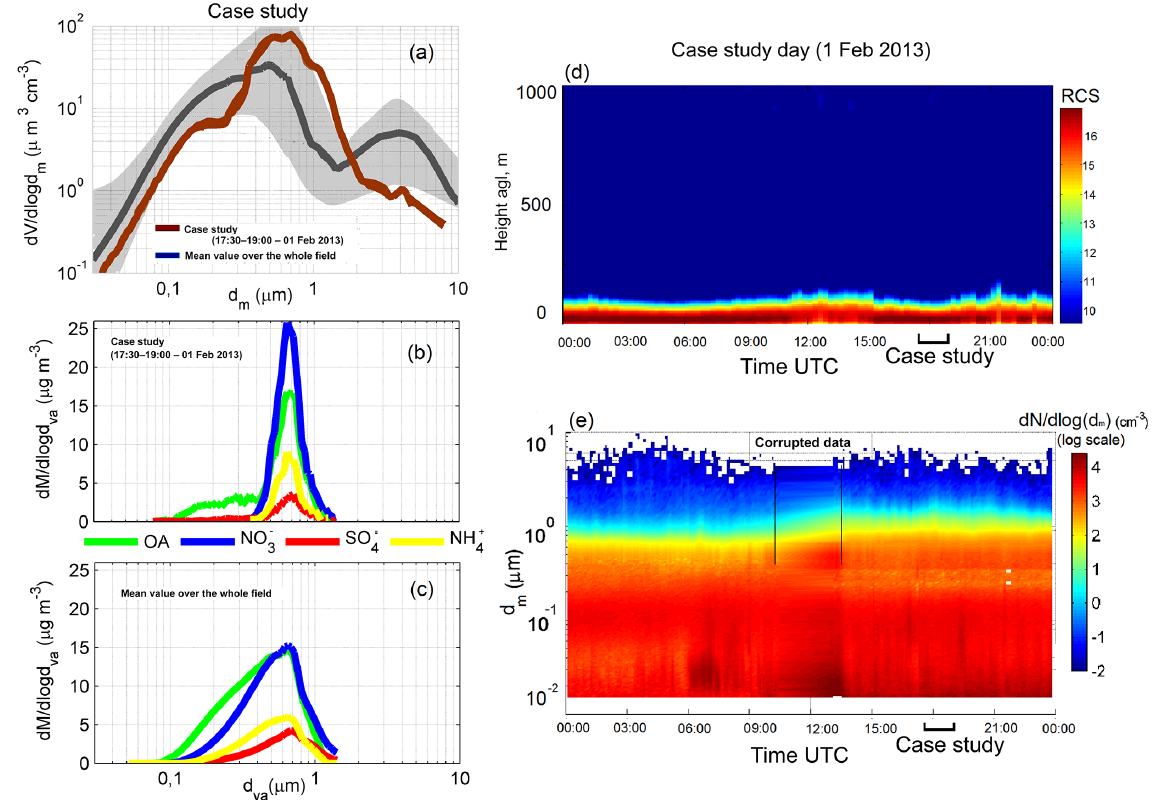
Figure 4. A case study illustrating BrC major features. Case study time period (1.5h) is from 17:30 to 19:00UTC on 1 February 2013 (local time at the Po Valley sampling site in this period is UTC + 1h). Case study values are compared with mean values over the whole field experiment. Panels illustrate (a) particle volume size distribution (d V/ dlog 10 d m , based on electrical mobility particle diameter d m ) during the case study and relevant mean values; (b) particle mass size distribution (d M/ dlog 10 d va , based on vacuum aerodynamic diameter, d va ) during the case study; (c) relevant mean values; (d) aerosol vertical profiles in the atmosphere during the entire case study day (time–height cross section of the range corrected signal, RCS = ln( S × R 2 ), from an LD40 ceilometer); (e) particle number size distributions during the entire case study